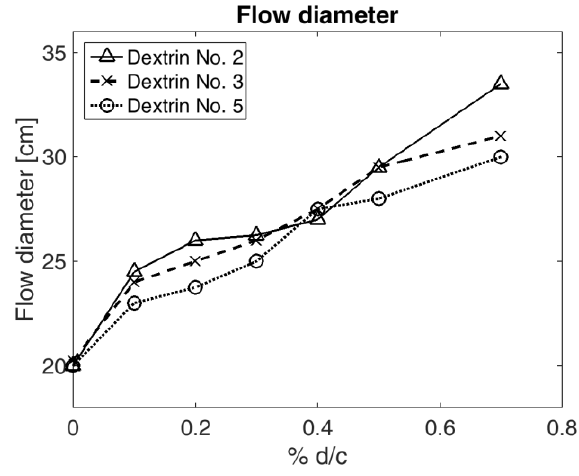
Figure 6. Cement mix flow.